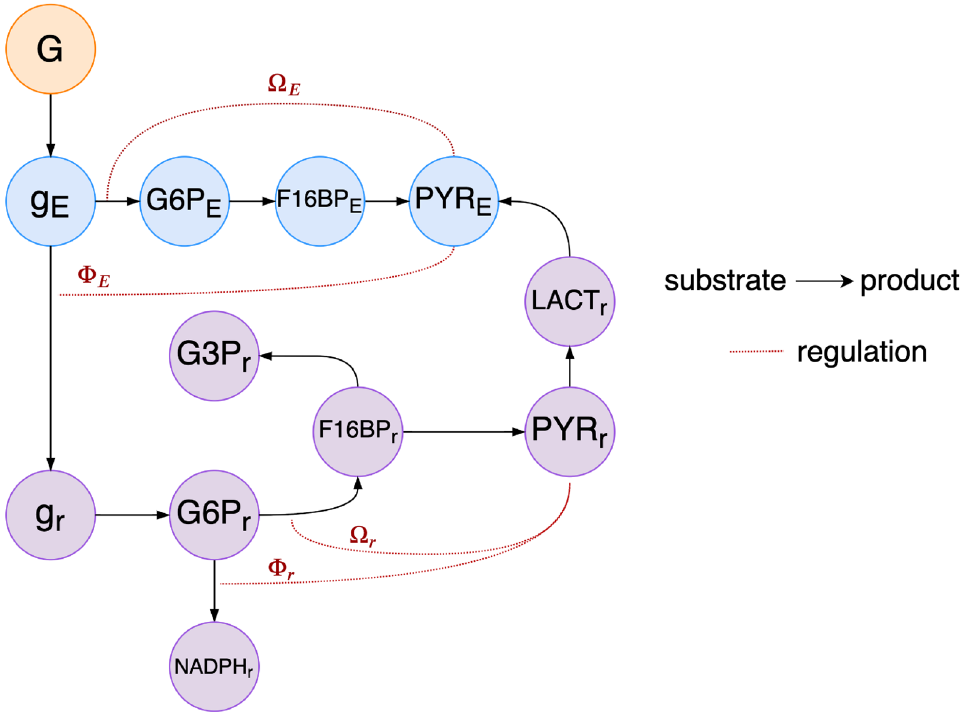
Figure 2. Network structure of the metabolite interactions in the rods and the RPE considered in our proposed mathematical model. Every node in the network represents the abundance of a specific metabolite. Blue nodes correspond to the metabolites in the RPE, denoted by the subscript E , and purple nodes correspond to the metabolites in the rods, denoted by the subscript r . The orange node represents the extracellular glucose. The enzymatic reactions by which metabolites are used and produced are represented by links: a link x → y indicates that the concentration of metabolite y directly depends on the concentration of metabolite x , in a substrate → product manner. A link x −− ↓ indicates that the corresponding reaction is regulated by a mechanism dependent of metabolite x . The abbreviations used for the metabolites are: [g z ]( t ) for glucose inside the cell, [G6P z ]( t ) for glucose 6-phosphate, [F16BP z ]( t ) for fructose 1,6-bisphosphate, [NADPH z ]( t ) for nicotinamide adenine dinucleotide phosphate, [PYR z ]( t ) for pyruvate, [LACT z ]( t ) for lactate, and [G3P z ]( t ) for glyceraldehyde